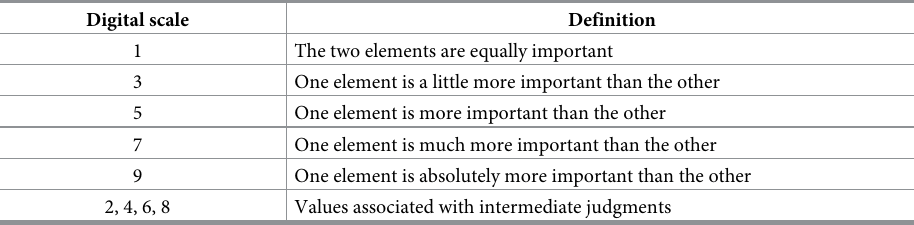
Table 2. Green and low-carbon expressway evaluation system rating scale.